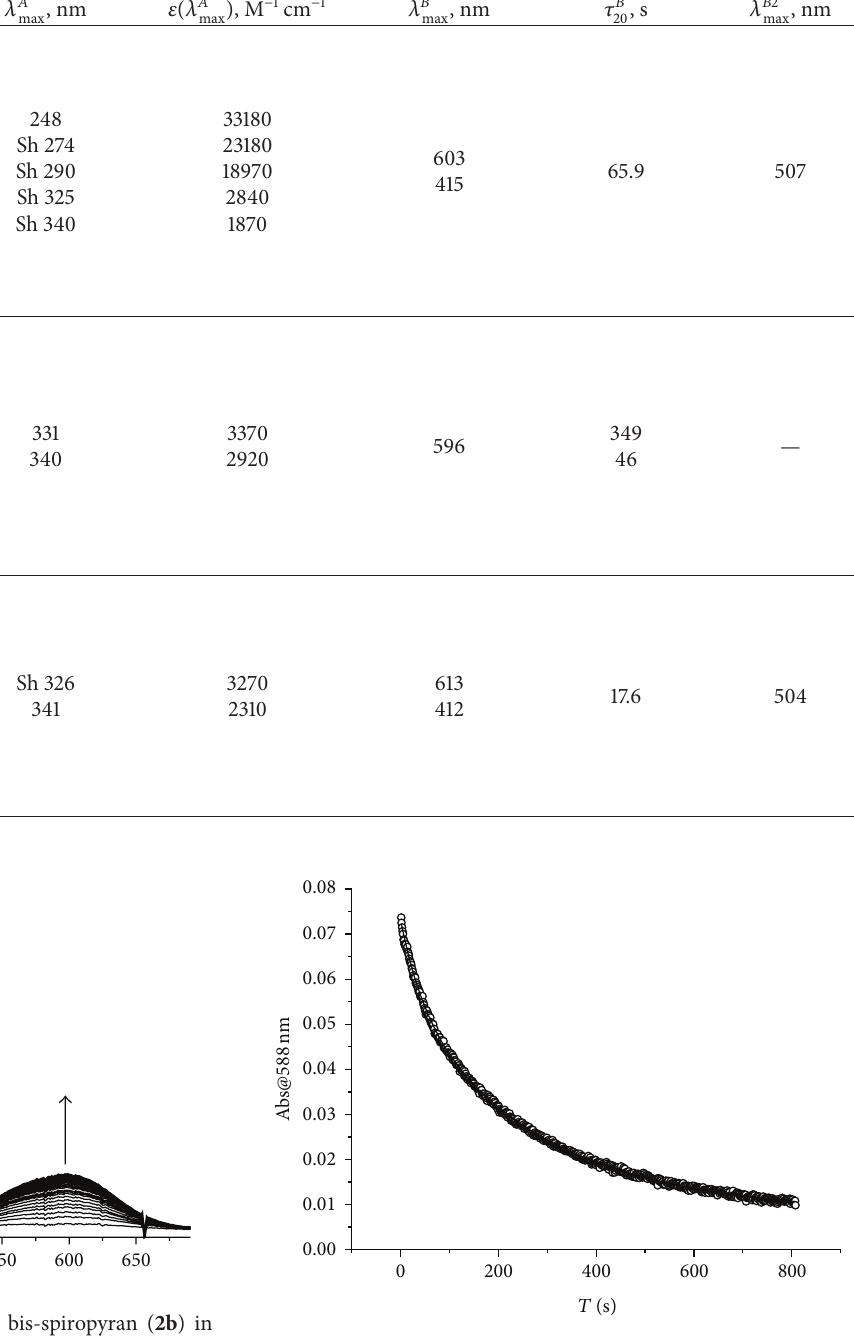
= 588 nm) of the thermal bleaching Figure 11: Kinetic curve ( 𝜆 obs reaction for( 2b ) ( [ c ] = 1.86⋅10 −4 M; 𝑇 = 293 ∘ K) intoluene